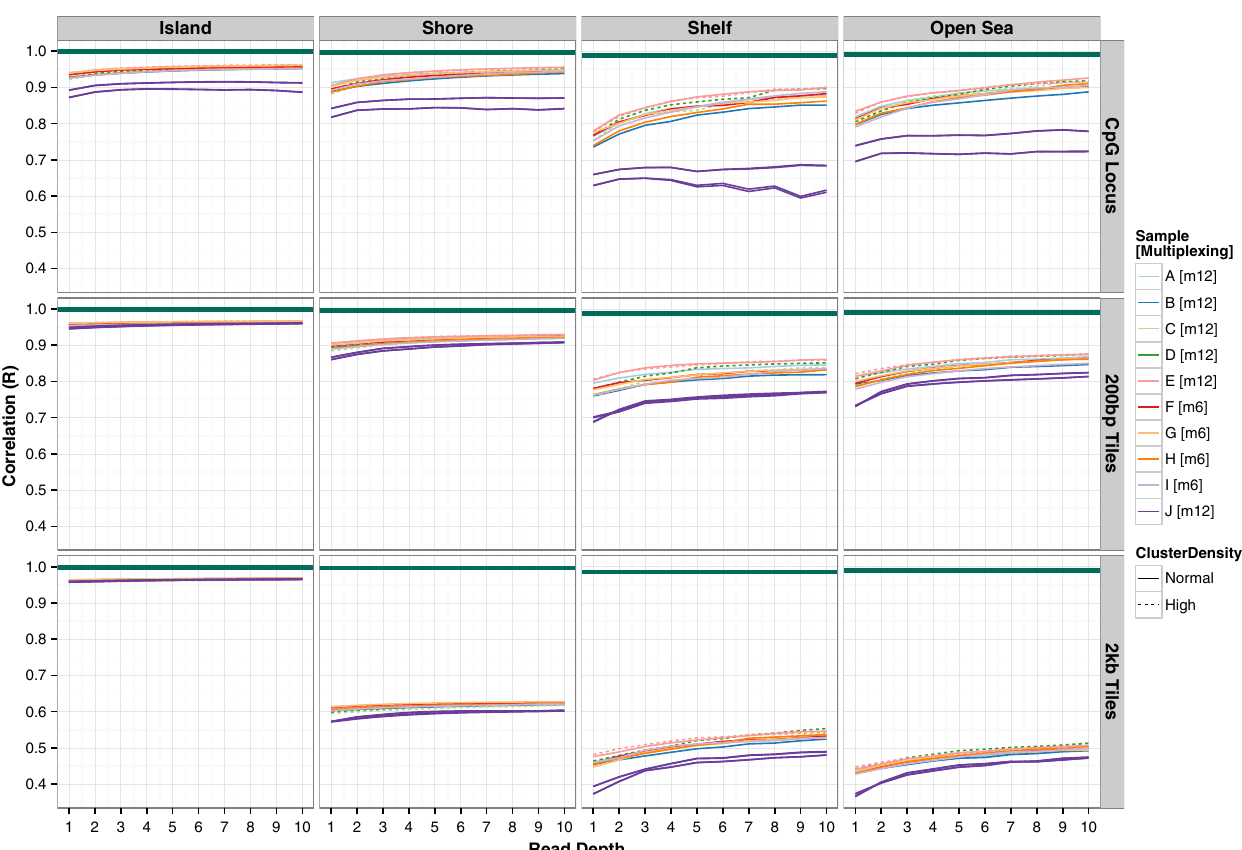
Fig. 5 Concordance of rmRRBS and In fi nium DNA methylation measurements. The Pearson correlations between DNA methylation measurements from 12 rmRRBS libraries derived from ten different participants ’ (labeled A – J) gDNA and DNA methylation measurements for the corresponding In fi nium HumanMethylation450 (450K) data derived from the same ten participants ’ gDNA is plotted from ≥ 1× to ≥ 10× rmRRBS reads. Results are strati fi ed by CpG resort context and shown for CpG loci, 200 base pair genomic tiles (200 bp tiles), and 2000 base pair genomic tiles (2 kb